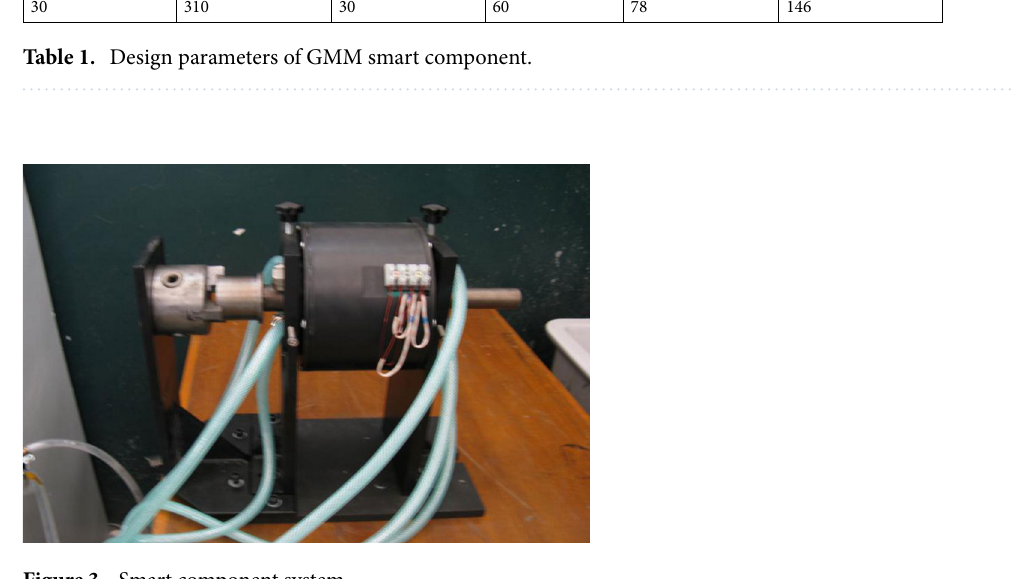
Diameter of component (mm)